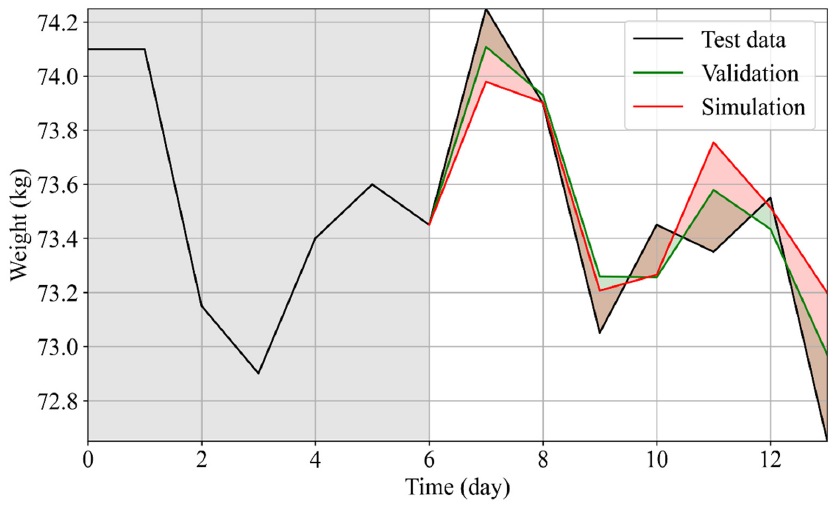
Figure 4. Comparison between actual data and WFV and WFS results for User 2.